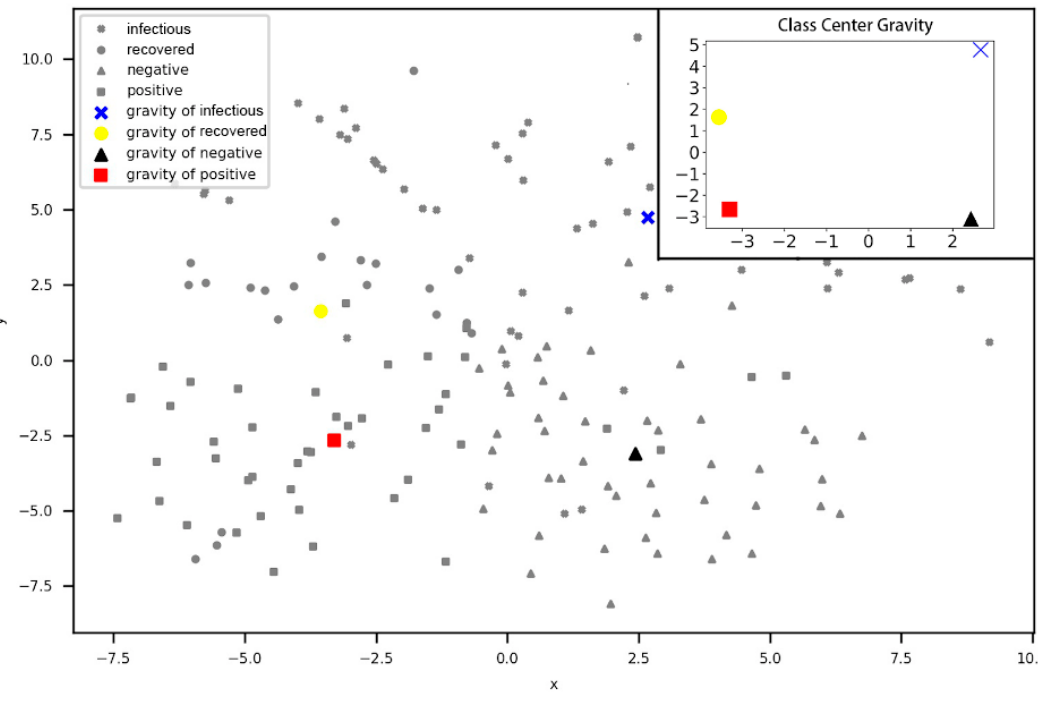
Figure 14. Class Center Gravity Scatter.